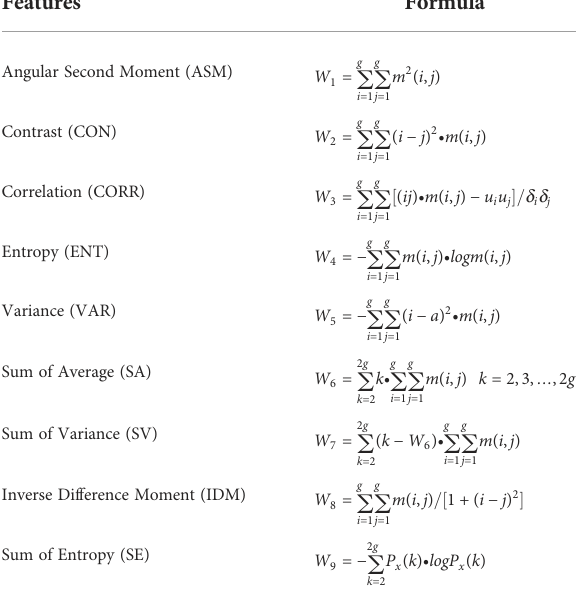
TABLE 2 The speci fi c calculation formula of texture features. Features